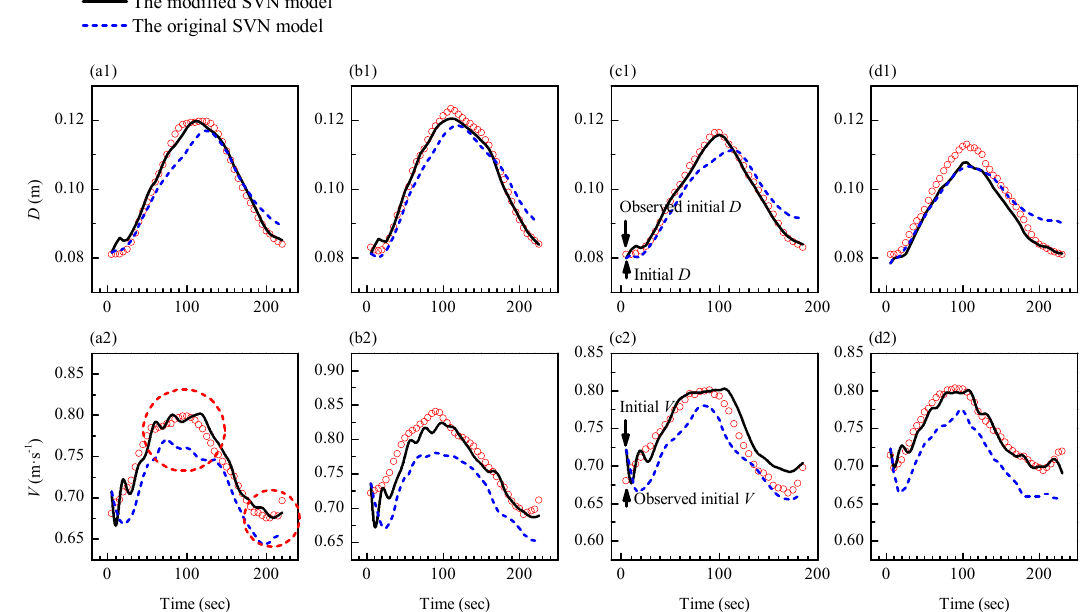
Figure 8. Simulation results of the modified and original SVN models during the four flood events: ( a1 ) flow depth hydrograph and ( a2 ) sectional averaged velocity hydrograph for No. 1-1 flood event; ( b1 ) flow depth hydrograph and ( b2 ) sectional averaged velocity hydrograph for No. 1-2 flood event; ( c1 ) flow depth hydrograph and ( c2 ) sectional averaged velocity hydrograph for No. 2-1 flood event; and (d1) flow depth hydrograph and ( d2 ) sectional averaged velocity hydrograph for No. 2-2 flood event.